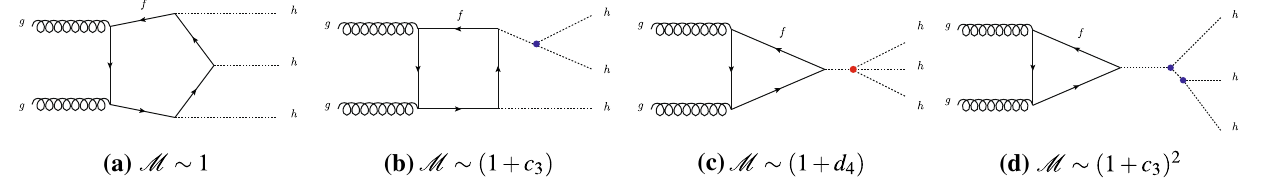
matrix elements unmodified by the anomalous couplings (at this order), b produce terms ∝ ( 1 + c 3 ) , c ∝ ( 1 + d 4 ) and d ∝ ( 1 + c 3 ) 2 . The interference of such diagrams produces the terms that appear in Eq. 4